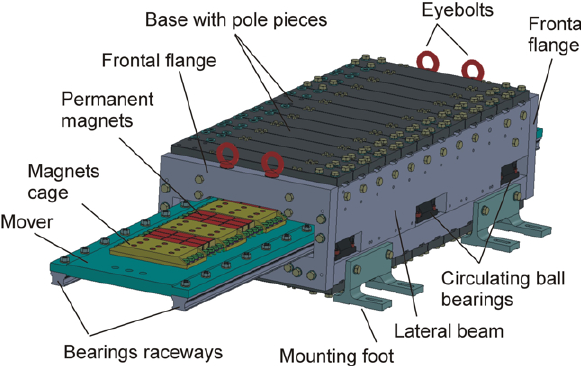
Figure 5: Solid modelling of the electromagnetic